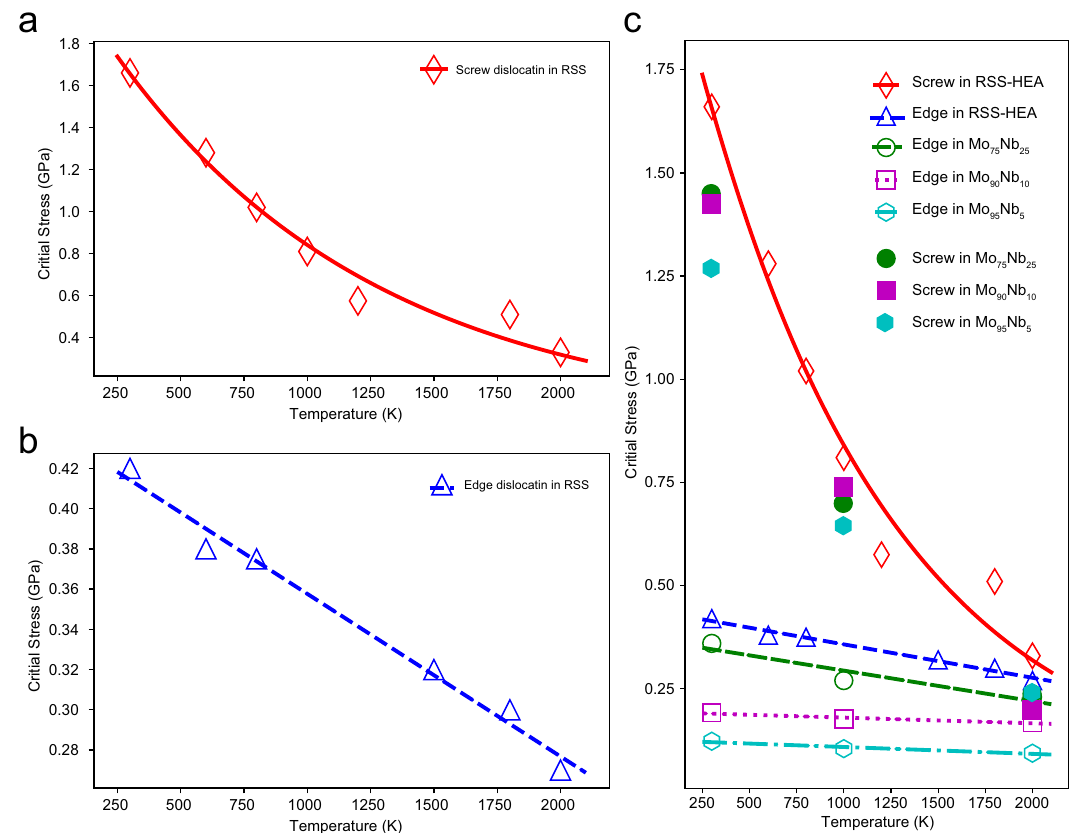
Fig. 8 Critical friction stress as a function of temperature for screw and edge dislocations. a Critical stress as a function of temperature for the screw dislocation in RSS samples obtained from MD simulations (open symbols), fi tted with an exponential function (solid line). b Critical stress as a function of temperature for the edge dislocation in RSS samples obtained from MD simulations (open symbols), fi tted with a linear function (solid line). c Comparison of critical stresses for screw and edge dislocations as a function of temperature. The critical stresses for edge and screw dislocations in Mo – Nb binary alloys are included for